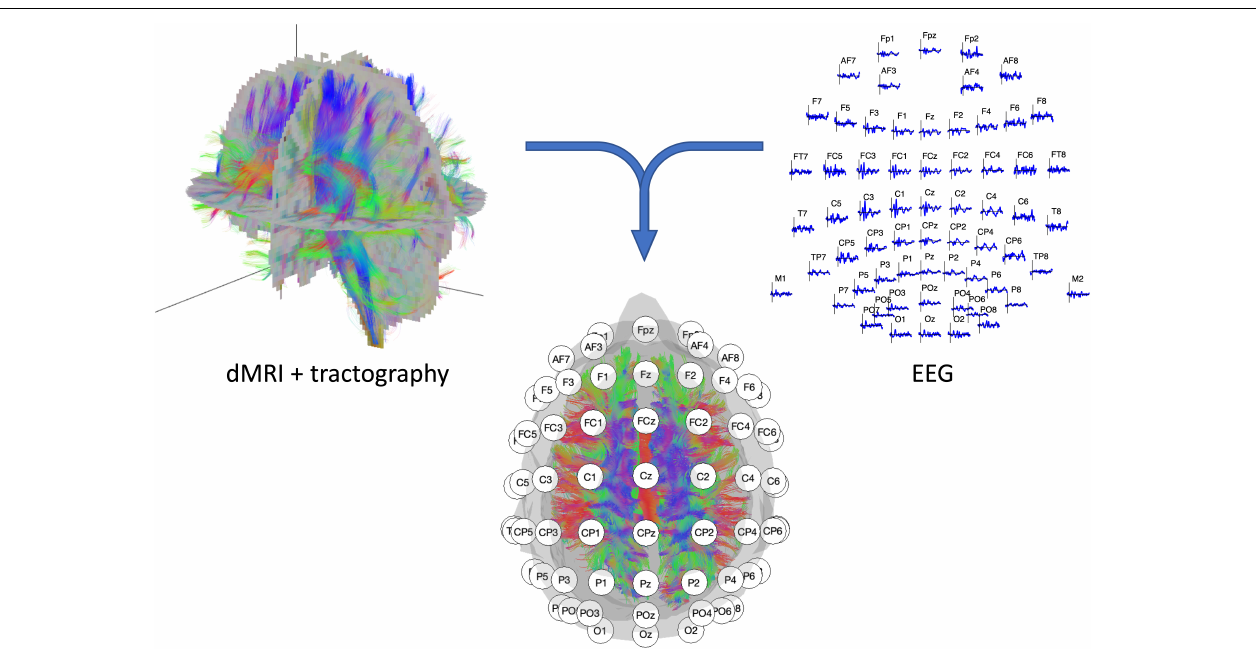
FIGURE 1 | Illustration of the two recording modalities. (Left top panel) dMRI recording with resulting fiber tracts. (Right top panel) 64-channel EEG signal with electrode layout conform the 10–20 systematic. (Middle lower panel) EEG/dMRI combination to explore the link between structural and functional